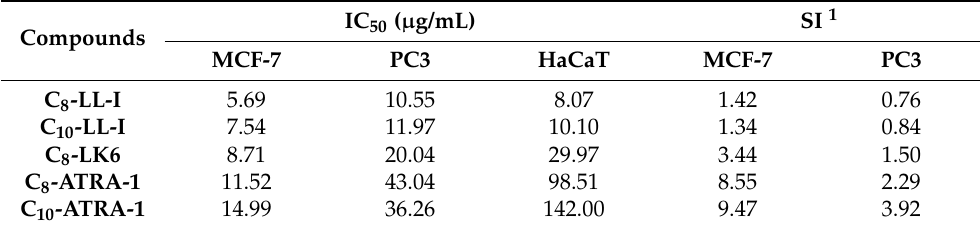
Table 2. IC 50 values and selectivity indexes (SI) of studied